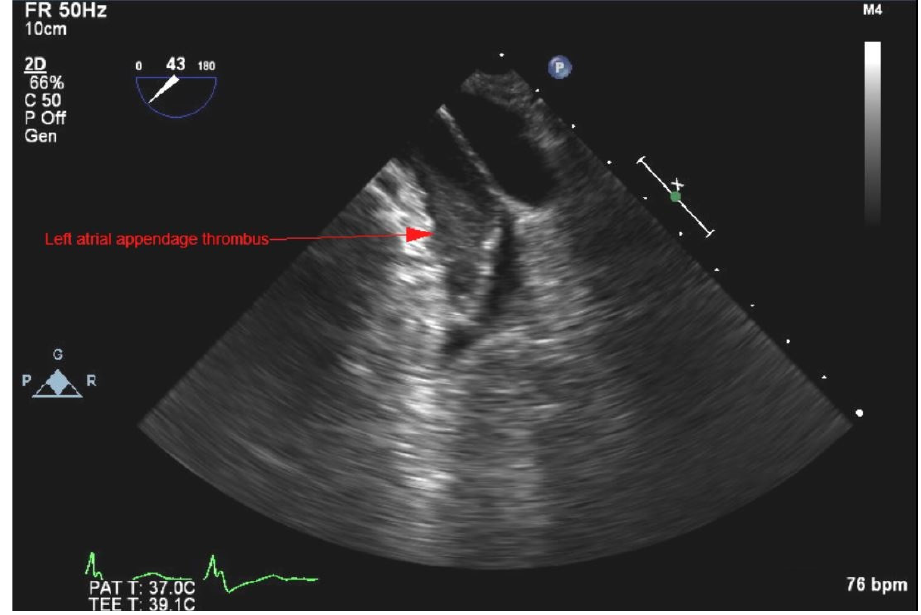
Figure 4. TEE view showing left atrium (LA) appendage thrombus.